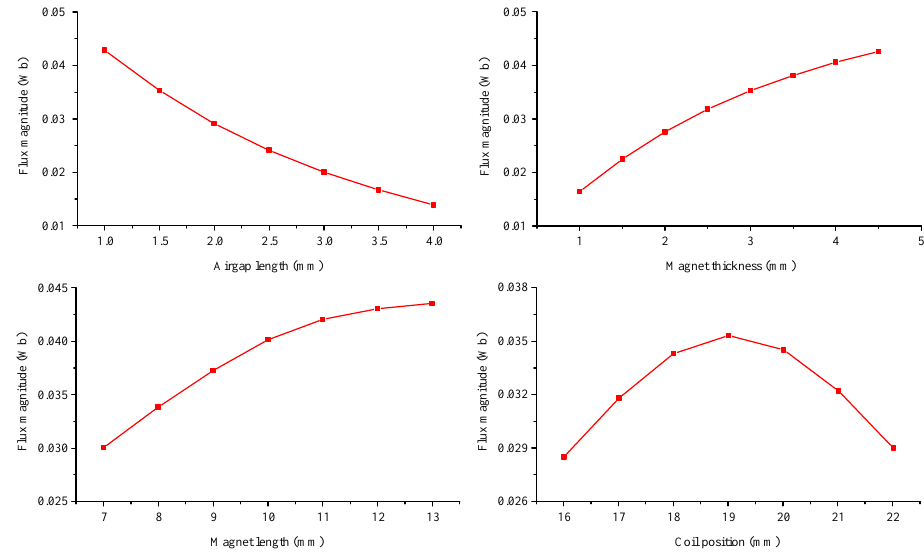
Figure 7. Magnitude of magnetic flux through coils varying with dimensional parameters.